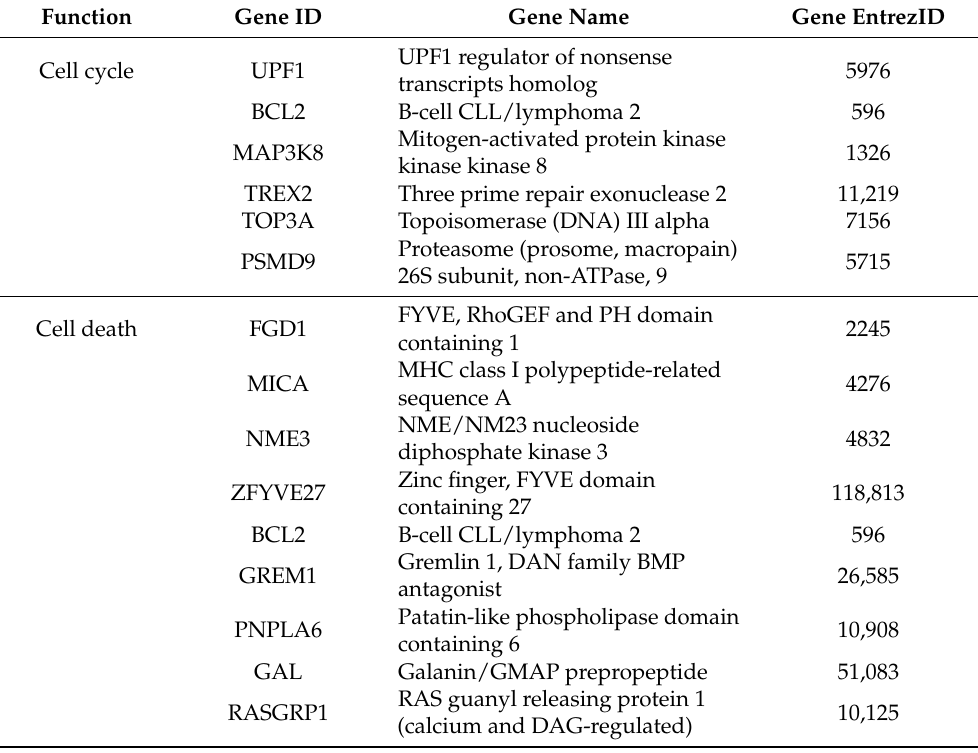
Figure 5. Enrichment scores for biological functions of differentially expressed genes in C1QBP silenced breast cancer cells derived from the Partek Genomics Suite 6.6 software (Partek Inc., St. Louis, MI, USA). Table 1. Categorization of genes associated with cell cycle and cell death using DAVID.